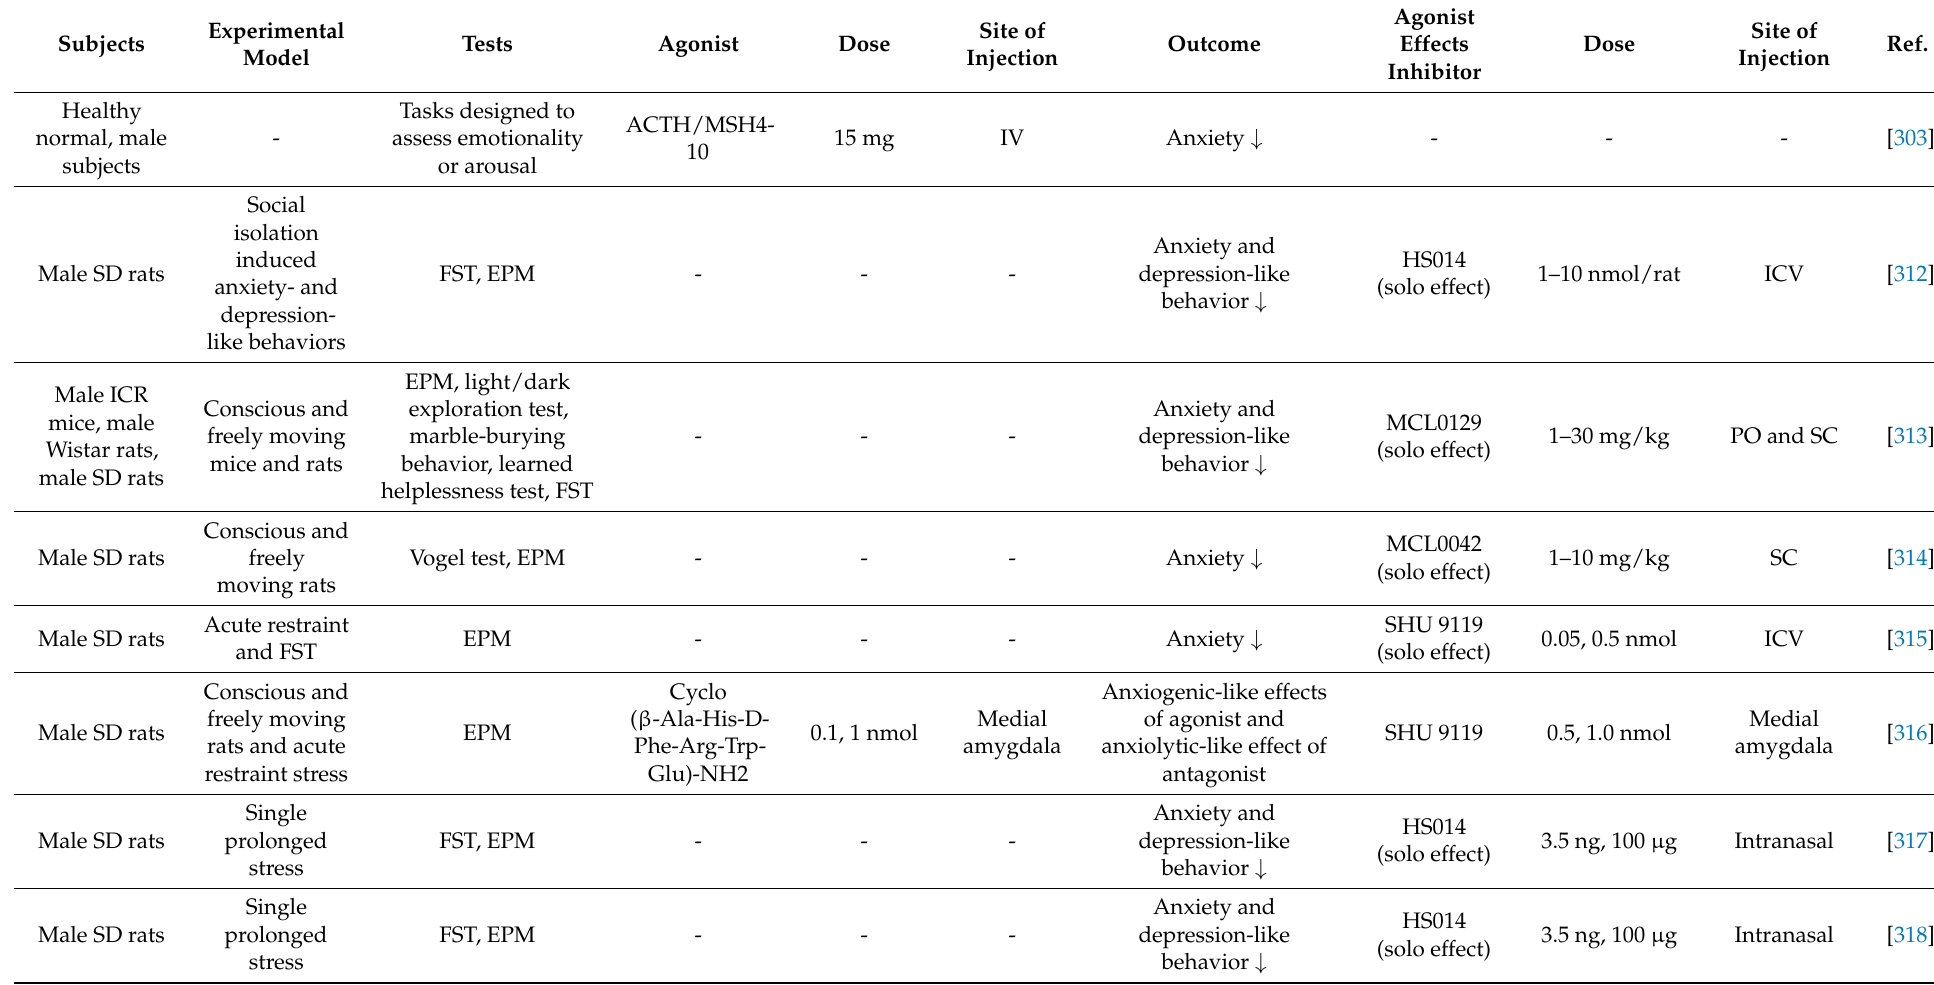
Table 6. A summary of the effects of melanocortin agonists on depression-like and anxious